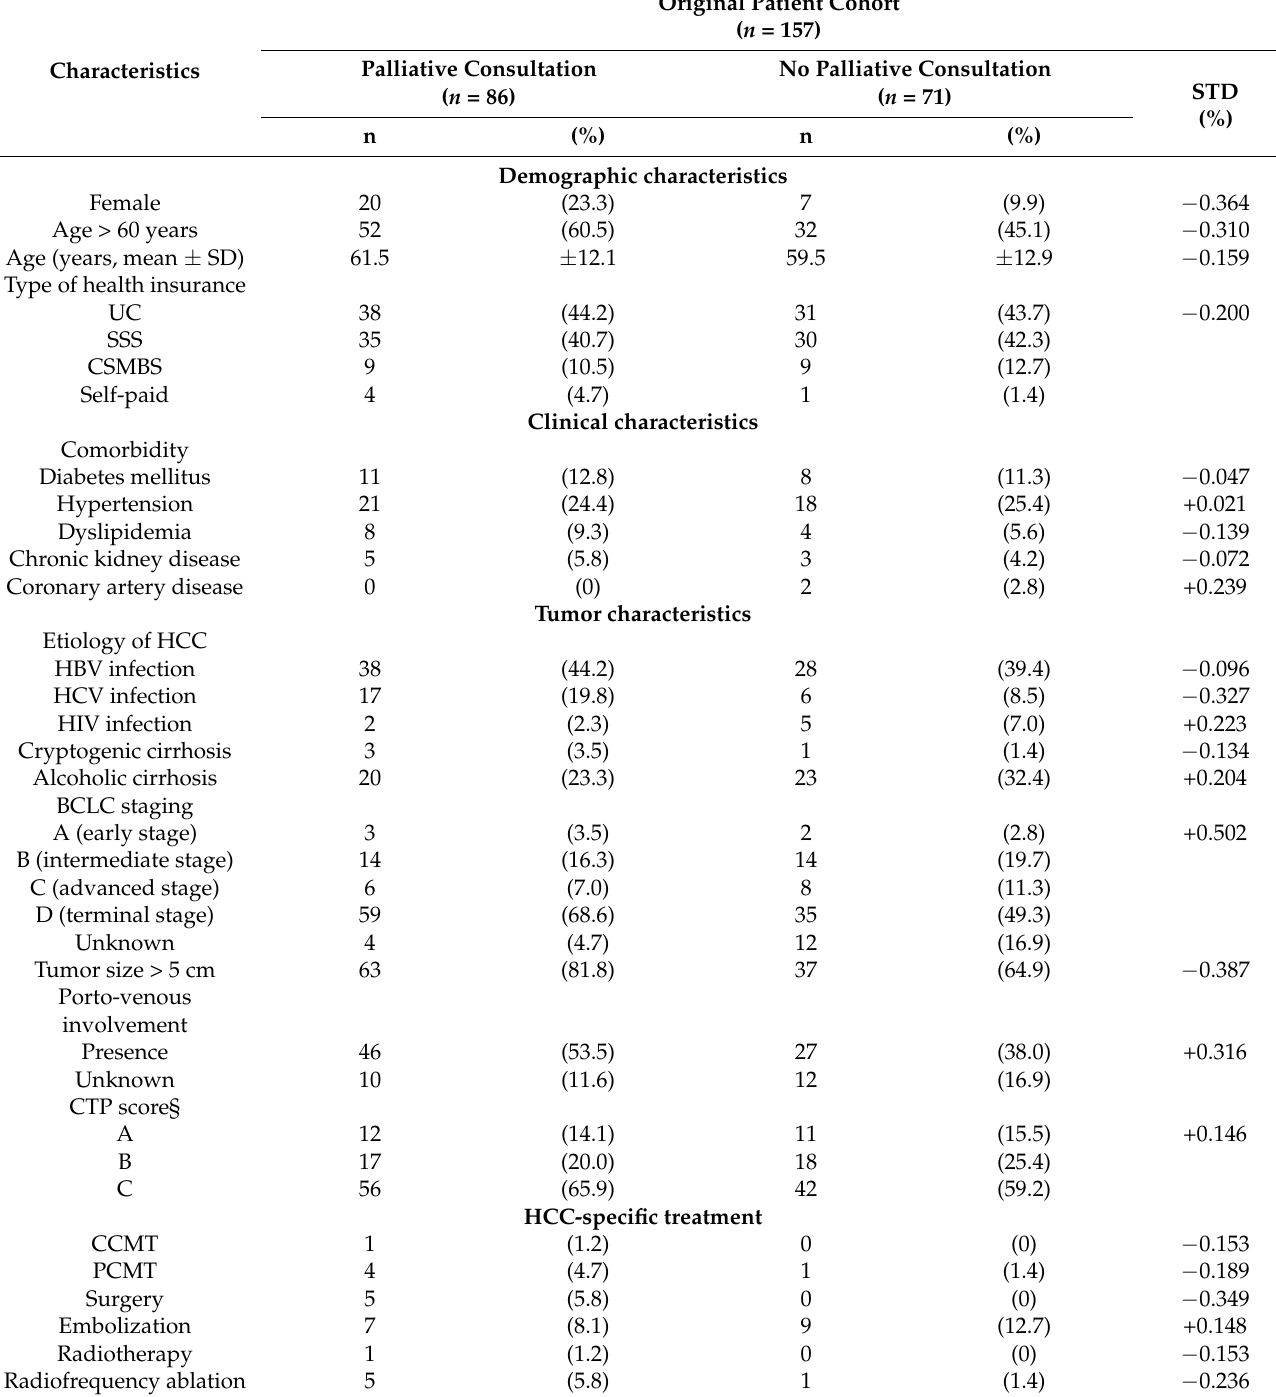
Table 2. Demographic, clinical, and tumor characteristics and HCC treatment of the original patient cohort.